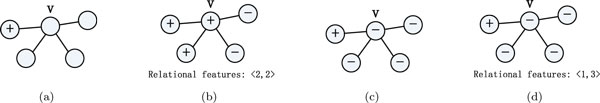
An example of ICA algorithm learning with limited labeled data. (a) initial state, train classifier MA and classify VU; (b) Compute relational features XR , train classifier MAR; (c) re-predict VU (use MAR); (d) re-compute relational features XR . ICA repeats step c and step d until a fixed iteration number.